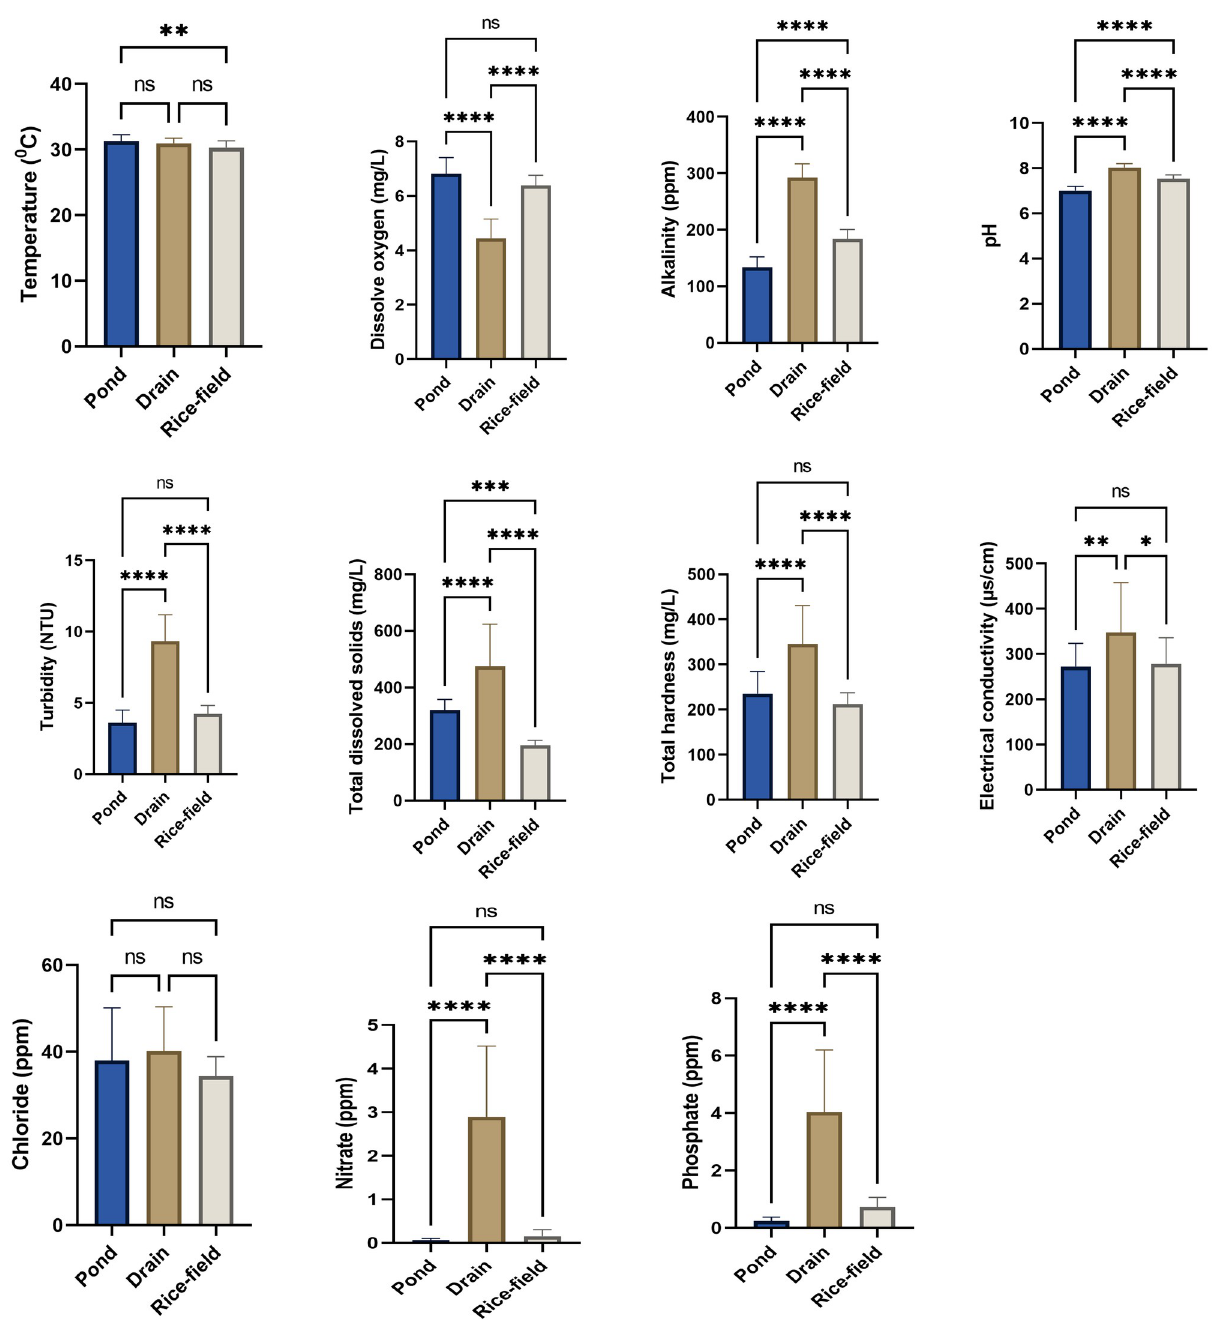
Fig 2. Physico-chemical parameters of different habitat types during summer season. An asterisk above given bar indicates significant difference. ‘ ���� ’ indicates p < 0.0001, ‘ ��� ’ indicates p < 0.001, ‘ �� ’ indicates p < 0.01, ‘ns’ indicates p > 0.05. conductivity (0.60) were found to positively corelated with F1, whereas, D.O (-0.93) & L.D (-0.65) were found to be negatively correlated with F1. On the other hand chloride (0.63), L.D (0.59) & TDS (0.52) were found to be positively correlated with F2, while pH (-0.48) & alkalin- ity (-0.34) were negatively corelated with F2 (S6A–S6C Table). During monsoon season F1